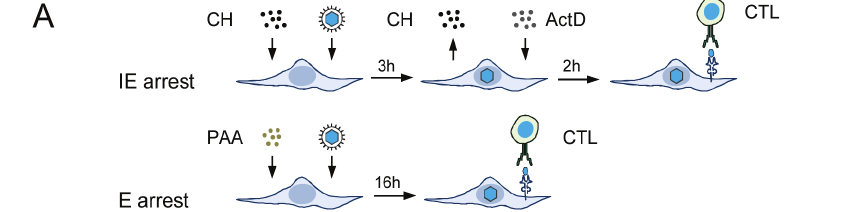
of defined antigenic peptide specificities; ( B ) Scheme of the mutagenesis rationale for modification of m164 protein antigenicity and immunogenicity in recombinant viruses. Shown is an overview map of the mCMV genomic region encompassing ORFs m163 - m165 . ORFs are symbolized by boxes, with the blue box representing ORF m164 encoding protein gp36.5 that comprises the intrinsic antigenic peptide AGPPRYSRI, which is presented by the MHC-I molecule H-2 D d . Hatched boxes indicate overlaps with neighboring ORFs. Amino acid sequences of the intrinsic and the replacing transgenic CD8 T-cell epitope, which is presented by H-2 K b , are shown in blue and green one-letter code, respectively. The C -terminal residue mutation to Ala is highlighted by red capital letter. Epitope-flanking residues are shown in smaller font; ( C ) Frequencies of cells of the indicated CTLL that respond in an IFN- γ -based ELISpot assay to sensitization by MEF of the presenting MHC haplotype infected with the indicated viruses under the indicated conditions of gene expression phase arrest. (Left two panels) Bars represent most probable numbers determined by intercept-free linear regression analysis based on triplicate assay cultures and graded numbers of CTL seeded; error bars indicate the 95% confidence intervals. n.i., no infection (uninfected MEF); ActD, MEF infected for 5 h in the presence of ActD preventing transcription from the very beginning; UV-IE, IE conditions applied to cells mock-infected with virus inactivated by UV-light (254 nm, ca. 4500 J/m 2 ). IE and E, MEF infection under conditions of IE and E phase arrest, respectively, as explained above. (Right panel) Bars represent median values of absolute spot counts from triplicate assay cultures for CTL seeded in graded numbers as indicated. Variance bars show the